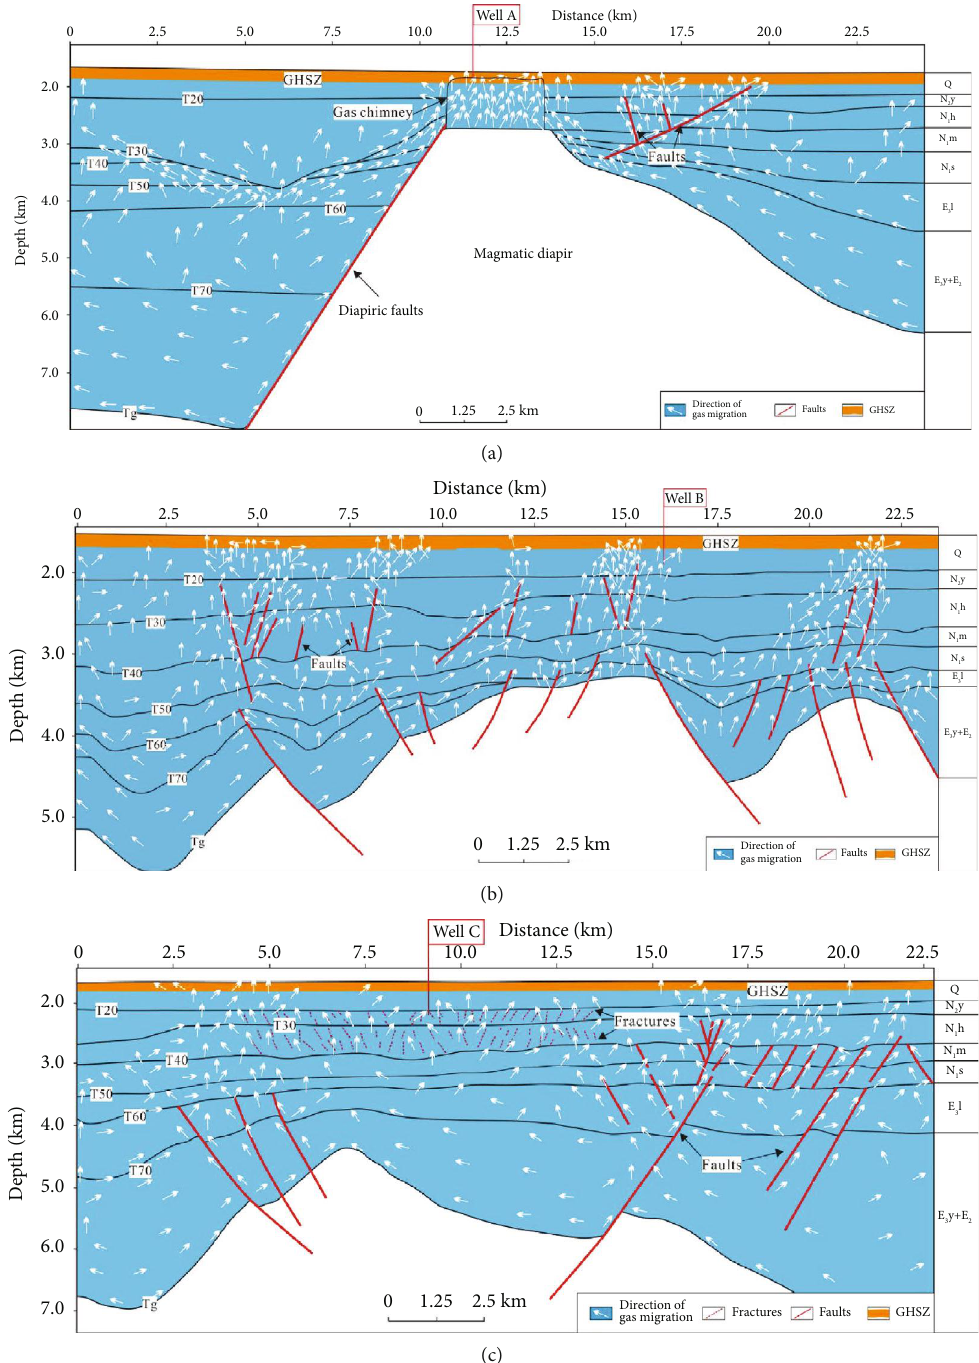
Figure 6: Natural gas migration simulation pro fi les of lines 1, 2, and 3 in the deep-water area of the